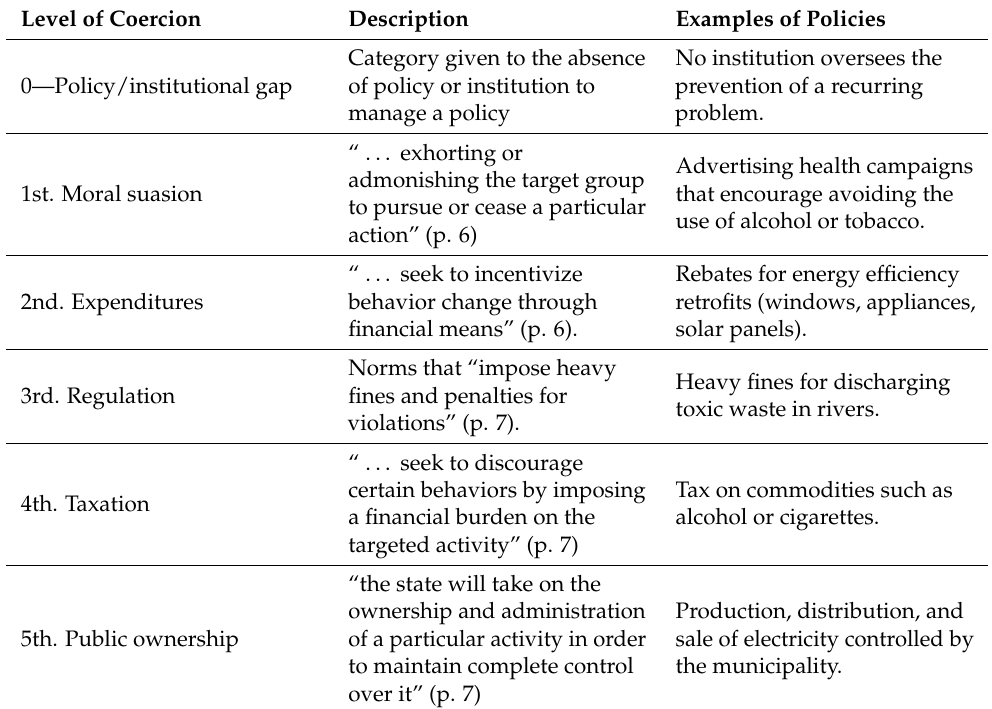
Table 1. The policy continuum for coercion